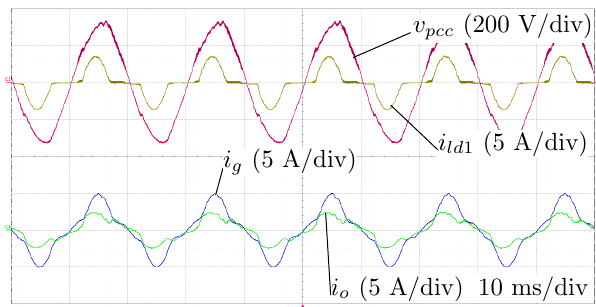
Figure 9. Experimental results when the voltage support loop is not in operation, I ∗